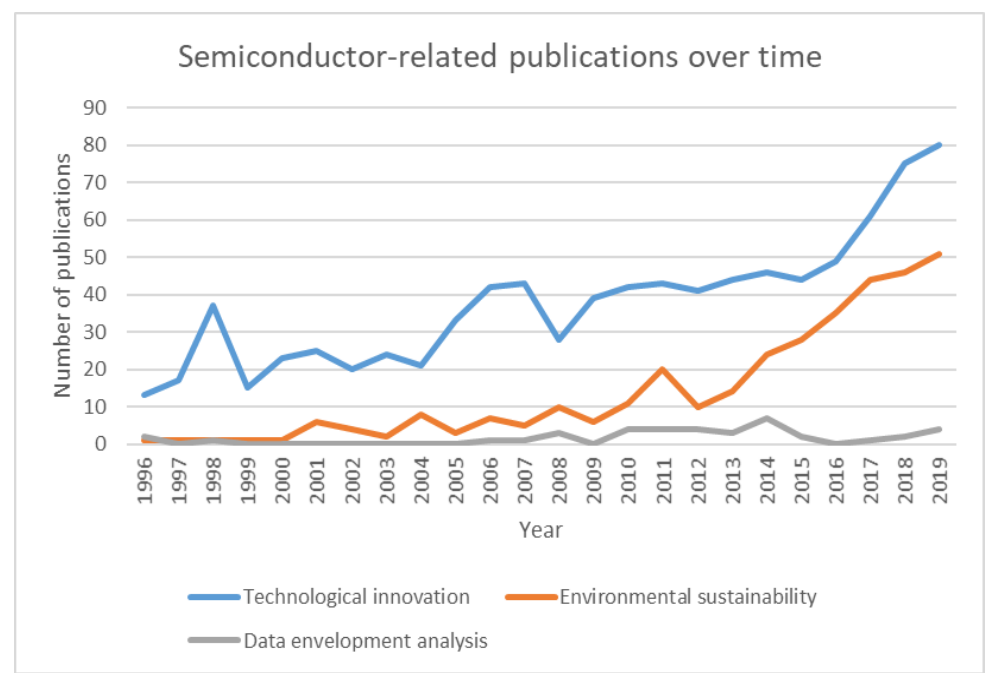
Figure 1. Semiconductor-related publications over time. Note: Keywords used in the Web of Science database are as follows: (semiconductor or “integrated circuit”) and (innovation or invention or patent or “intellectual property”), (semiconductor or “integrated circuit”) and (sustainability or “greenhouse” or “climate change”), and (semiconductor or “integrated circuit”) and (“data envelopment analysis”). While they are not a completely exhaustive list of keywords, we think that it may be sufficient to show their overall trends.